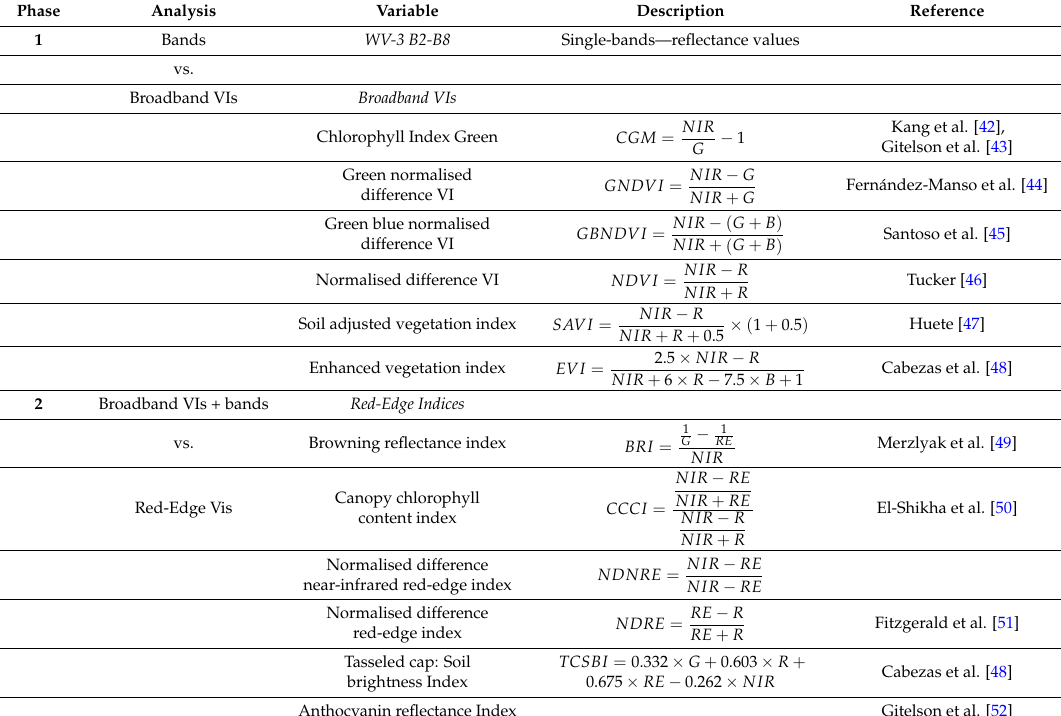
Table 2. Variable categories used in this